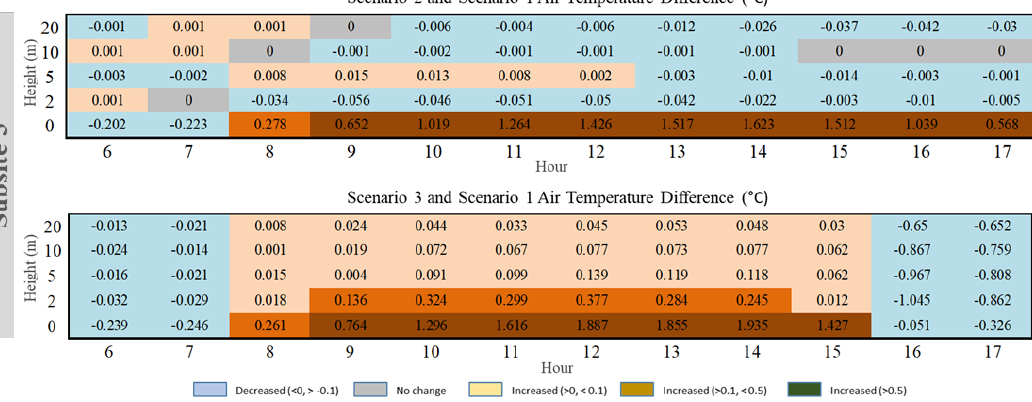
Figure 10. Air temperature differences between Scenarios 3 and 1, and Scenarios 2 and 1 in each of the subsites selected within lower Session Road, Baguio City. Temperatures highlighted in gray have not changed, blue have decreased, while orange, dark orange, and brown have increased. Scenario 3 consistently increased surface temperature across all atmospheric elevations especially for 1 and